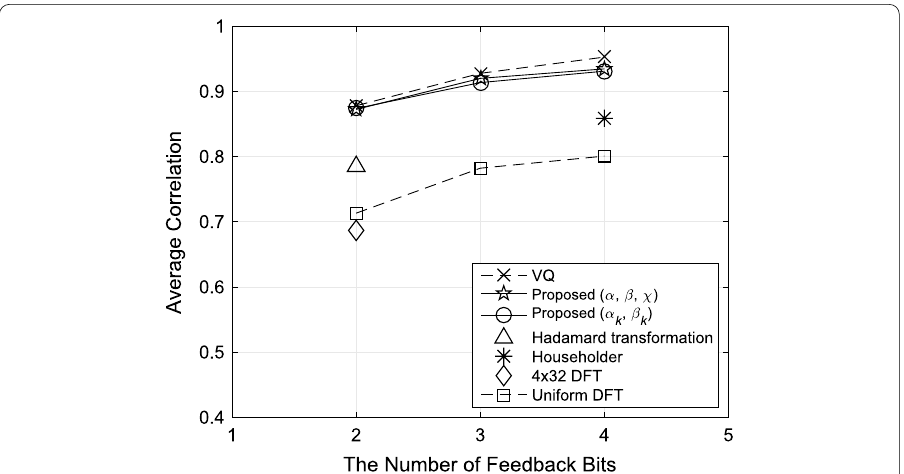
2 , 3 and 4 feedback =